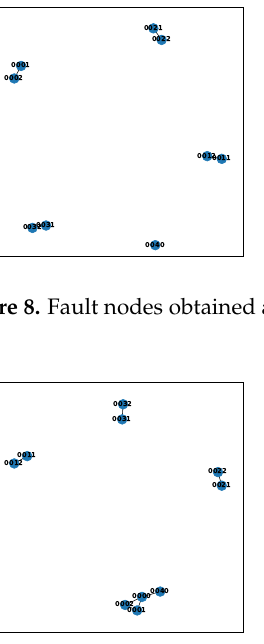
Figure 9. Fault nodes obtained after calling the UDiag algorithm.